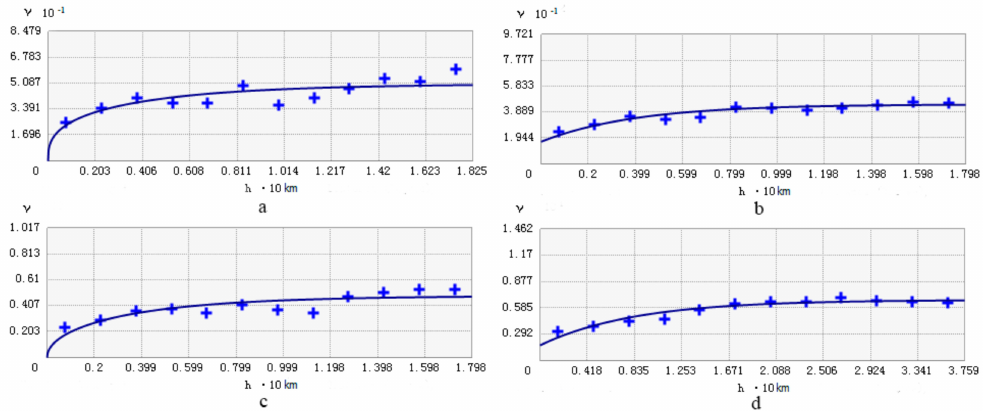
Figure 4. Semi-variograms of soil K + residuals for: ( a ) OK-Soil; ( b ) OK-Geology; ( c ) OK-Landuse; and ( d ) OK (original values).